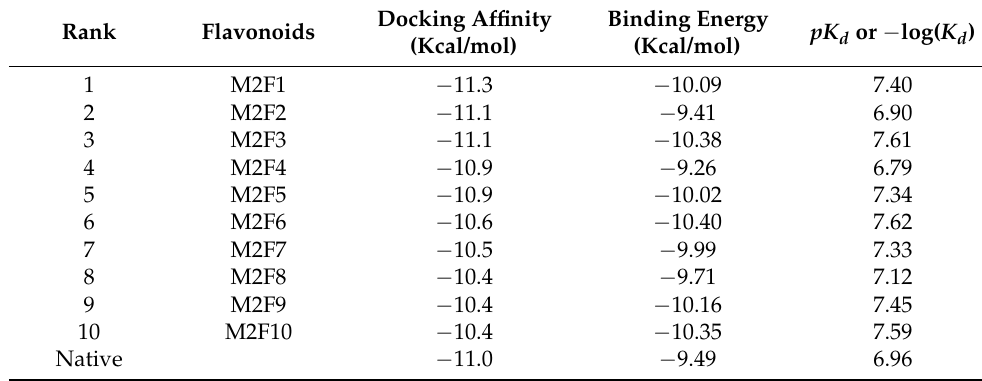
Table 2. The selected flavonoids and the binding strength score against MEK2 (Autodock Vina docking energy, X-score binding energy, and pK d ). The higher the absolute values of the scores, the better the